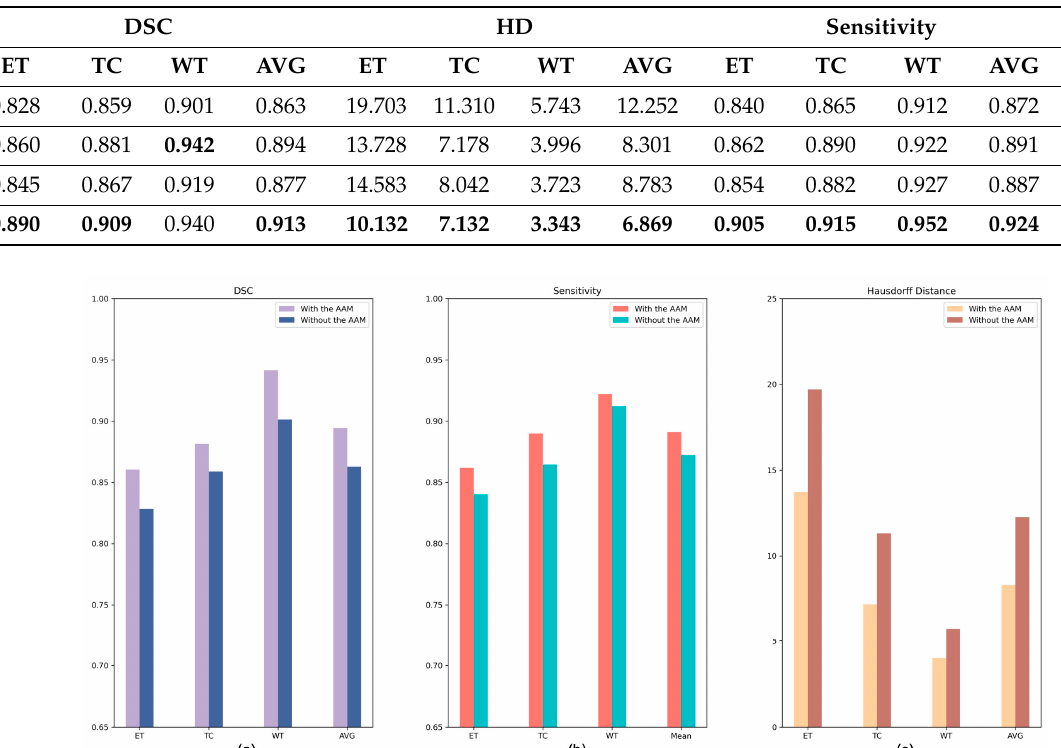
Figure 6. The performance indexes of the proposed AABTS-Net and the AABTS-Net without AAM. ( a ) represents the DSC value, ( b ) represents the Sensitivity value and ( c ) represents the HD value.